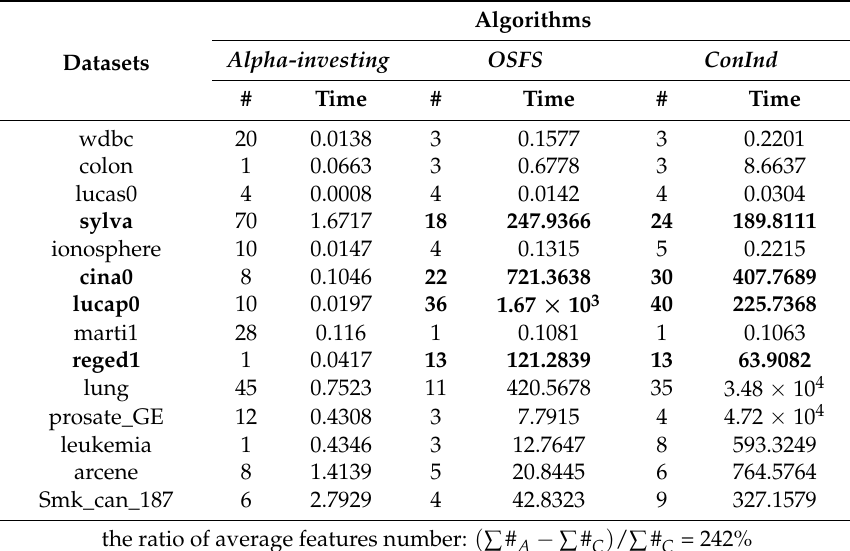
Table 6. The number of selected features and running